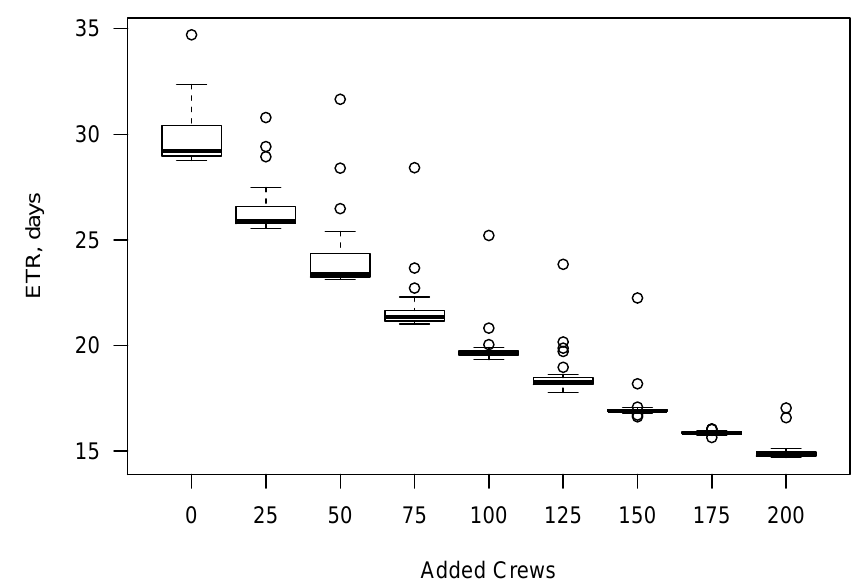
Figure 13. Changing the number of mutual assistance crews added to 200 initial crews for extreme storm with a two-day arrival time. Crew start location set to area work center and search strategy set to nearest outage. Travel speed set to 25 mph. 85% crews working during day shift, 99% working during evening shift and 66% working during night shift, 1 to 10 h repair time range. The ETR decreases with increasing number of mutual assistance